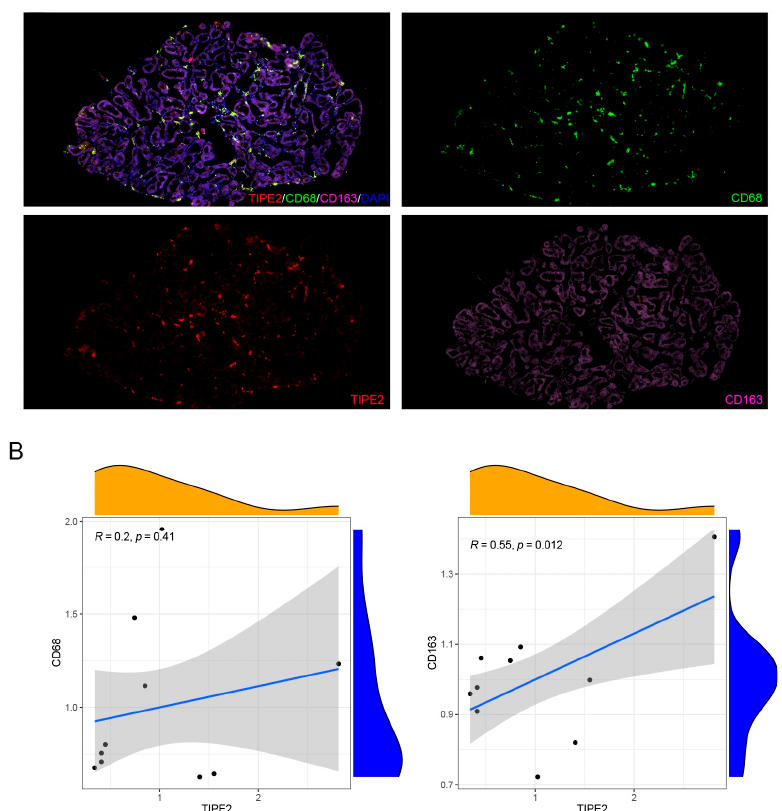
Figure 6. Immunofluorescence co-staining and the expression correlation between TIPE2 and markers of M1/M2 macrophages in MG tissues of MGD patients. ( A , B ) The results showed that the expression levels of CD68 were higher than CD163 in MG tissues of MGD. The expression level of TIPE2 was positively correlated with the expression level of CD163 (R = 0.55, p = 0.012). No significant correlation was found in the expression between TIPE2 and CD68 (R = 0.2, p = 0.41).